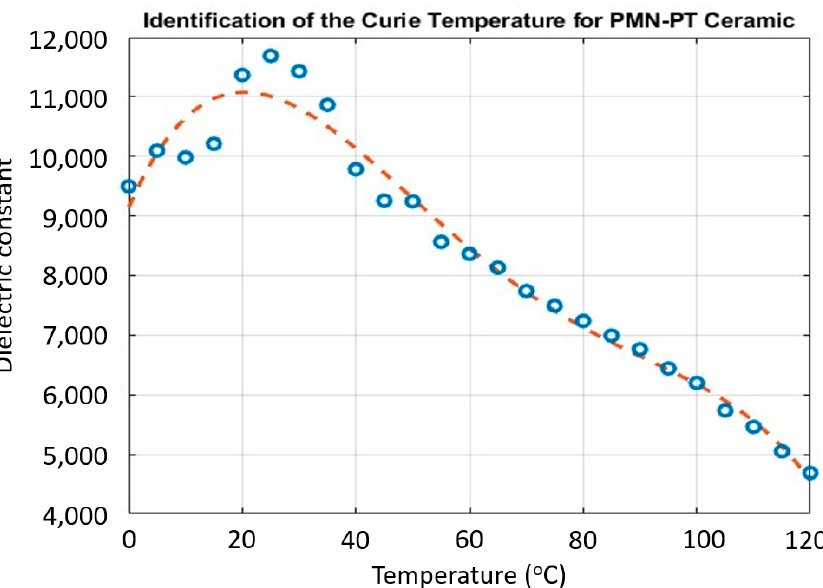
Figure 18. The dielectric constant for the PMN-PT ceramic as a function of temperature. The peak dielectric constant of 11,688.9 is reached at room temperature, approximately 25 °C.